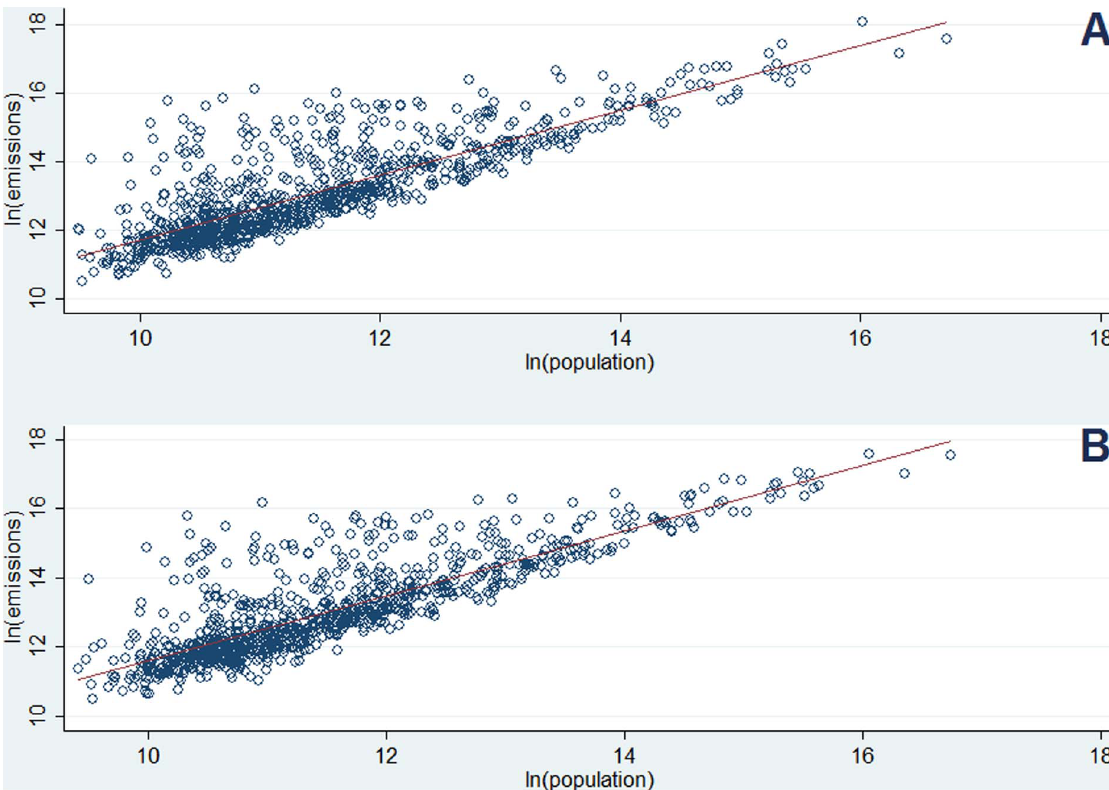
Figure 1. Cross-sectional log-log regressions for years (A) 1999 and (B) 2008.